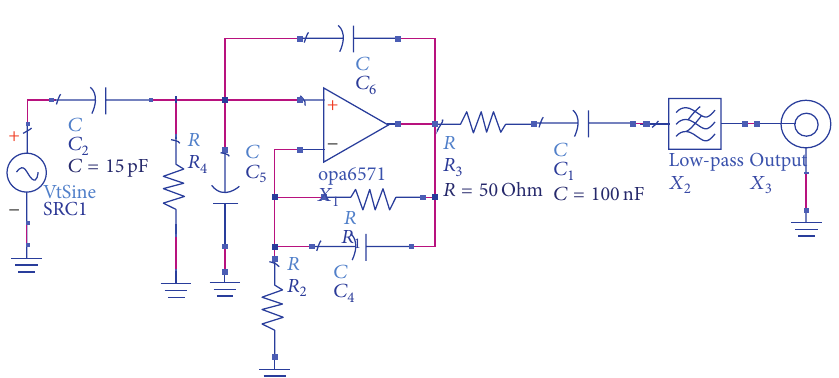
Figure 5: Schematic diagram of equivalent circuit for active receiving